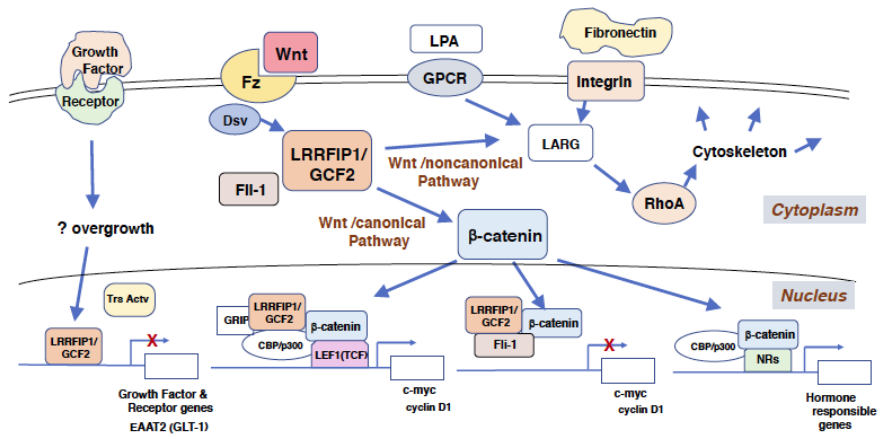
Figure 2. Roles of LRRFIP1/GCF2 in transcriptional repression, signal transductions, and regulation on the cytoskeletal